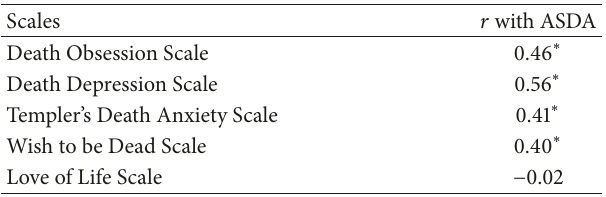
Table 3: Pearson correlations (𝑟) between the Arabic Scale of Death Anxiety (ASDA) and other scales in Iranian college students.